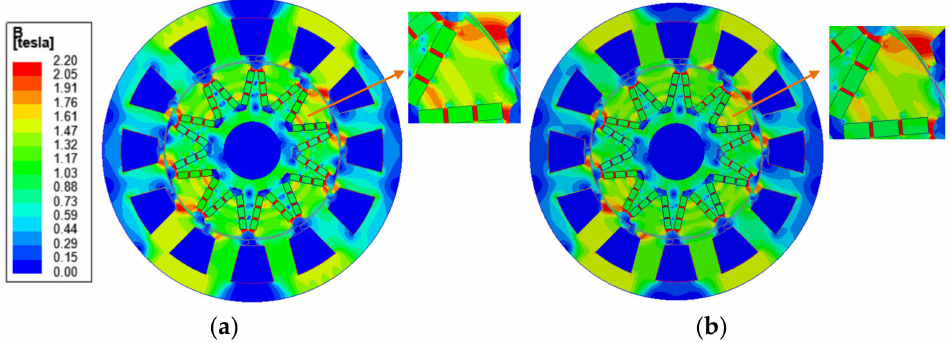
Figure 9. The field distribution of the initial motor and the optimized motor. ( a ) Initial motor. ( b ) Optimized